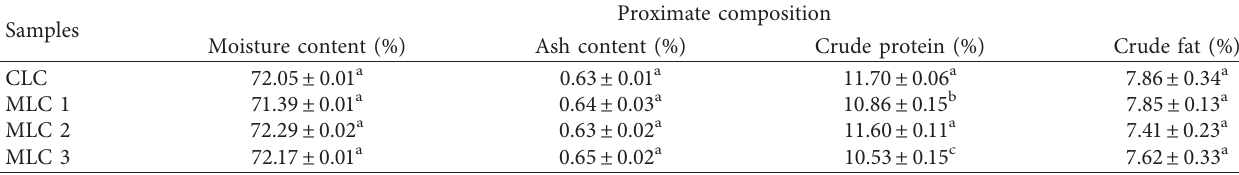
Table 10: Proximate composition of layer chicken meat obtained from a genuine supplier and three different markets.